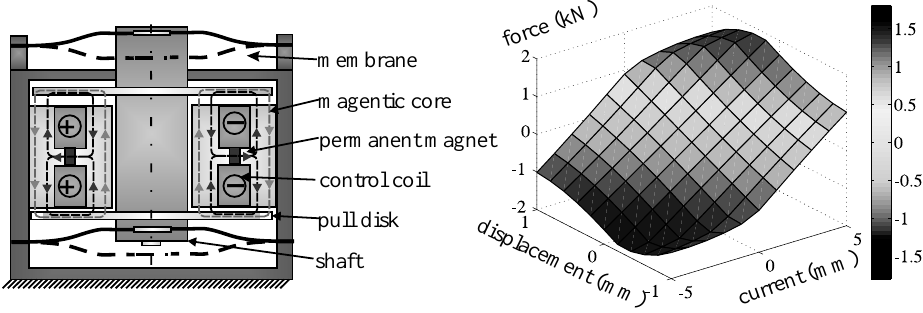
Fig. 3. Schematic of the actuator (left), force-field of the actuator